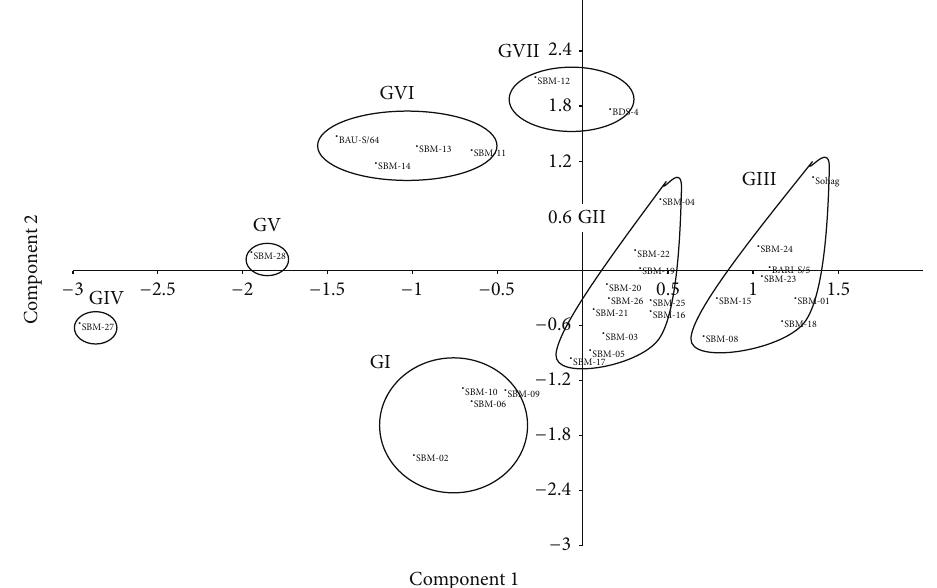
Figure 2: Two-dimensional plot of PCA showing relationships among 31 soybean genotypes using morphological and yield related traits. Note: BDS-4: Bangladesh Soybean-4; BARI-S/5: BARI